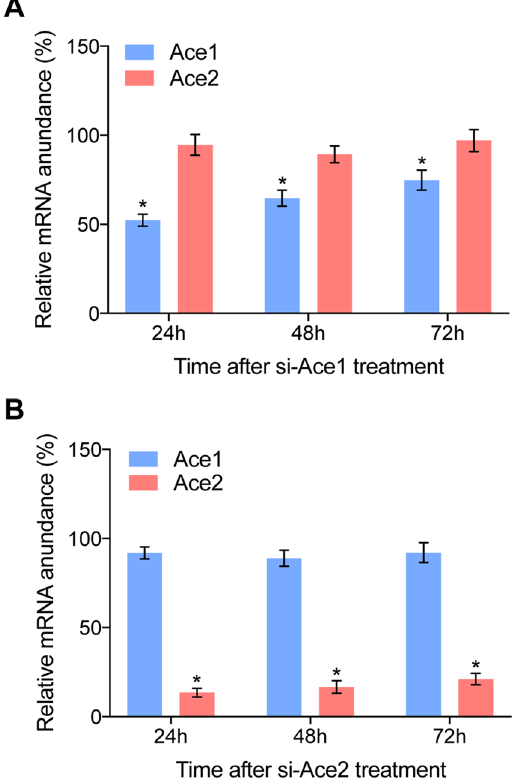
Figure 2. siRNA treatments led to reduced abundances of mRNA transcripts of BmAce1 and BmAce2 in silkworm. Panel A: siAce1 treatment led to decreased mRNAs encoding BmAce1 , but not BmAce2 . Panel B: siAce2 treatments led to reduced accumulation of mRNAs encoding BmAce2 , but not BmAce1 . For both panels, the histogram bars represent mRNA abundances and the error bars indicate 1 SEM. * Significant difference at P ≤ 0.05. All experiments were repeated in triplicate, n =